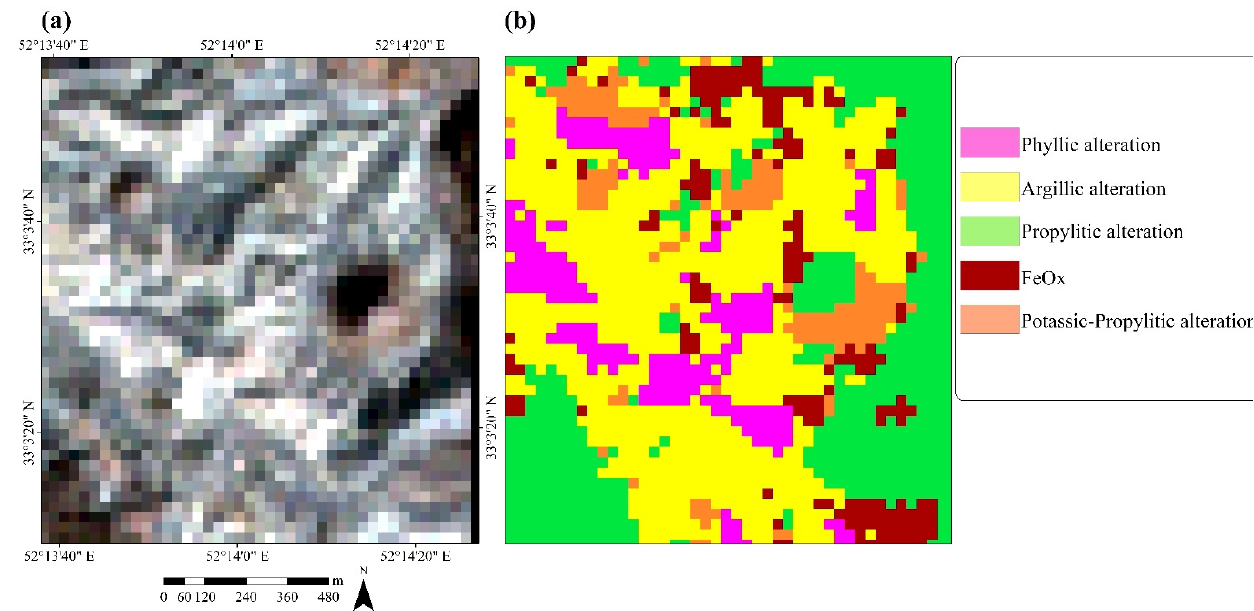
Figure 6. ( a ) The Zefreh ASTER image, ( b ) the DP clustering method results showing the spatial distribution of alteration zones in the study area.